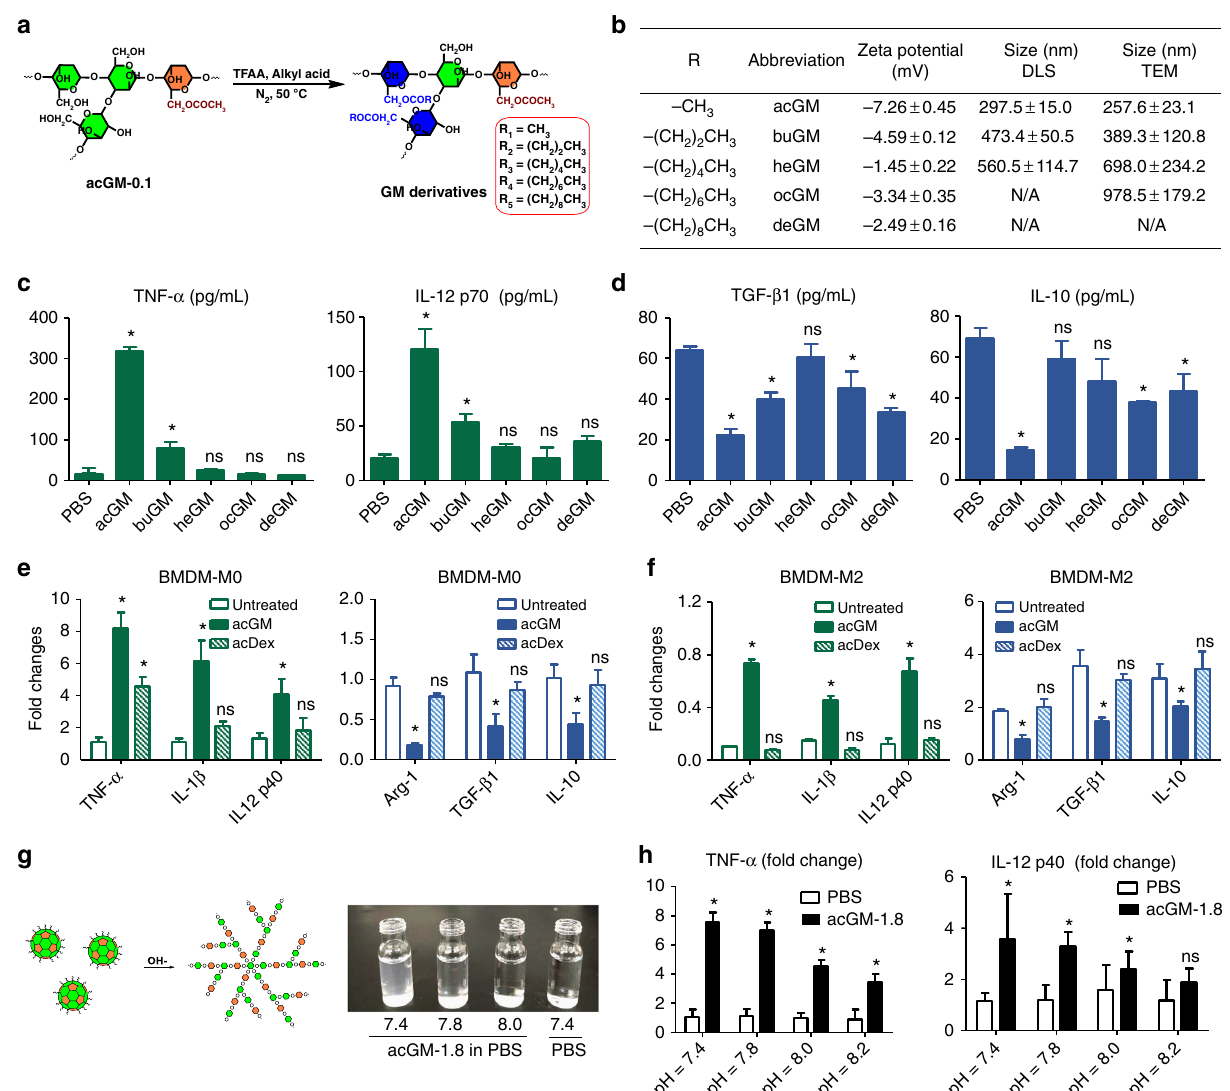
Fig. 3 Both “ ac ” and “ GM ” are essential for the function of acGM-1.8. a Schematic illustration of preparing different GM derivatives. b Physical properties of the GM derivatives, including the type of aliphatic chain, zeta potential, and size determined by both dynamic light scattering (DLS) and transmission electron microscopy (TEM). c , d Determination of ( c ) proin fl ammatory cytokines TNF- α and IL-12 p70 and ( d ) anti-in fl ammatory cytokines TGF- β 1 and IL- 10 secreted by BMDM after 24 h of stimulation by various GM derivatives (* P < 0.05 vs. the PBS group; n = 3). e Fold changes of markers for macrophage polarization (M1: TNF- α , IL-1 β , and IL-12 p40; M2: Arg-1, TGF- β 1, and IL-10) in BMDM (BMDM-M0) treated with PBS, acGM, or acetyl dextran (acDex) for 24 h (* P < 0.05 versus the PBS group; ns: no signi fi cance; n = 3). f Fold changes of markers for macrophage polarization (M1: TNF- α , IL-1 β , and IL-12 p40; M2: Arg-1, TGF- β 1, and IL-10) in pre-induced M2-type BMDM (BMDM-M2) treated with PBS, acGM, or acetyl dextran (acDex) for 24 h. (* P < 0.05 vs. the PBS group; ns: no signi fi cance; the fold changes were normalized to those of M0; n = 3). g (left) Schematic illustration of breaking the acGM assemblies by alkaline solution and (right) the appearance of acGM-1.8 in PBS under different pH values (7.4, 7.8, and 8.0) compared with PBS. h Fold changes of proin fl ammatory cytokines (TNF- α and IL-12 p40) expressed by BMDM after incubation with PBS or acGM-1.8 under different pH values (7.4, 7.8, and 8.0; * P < 0.05 versus the PBS group; ns: no signi fi cance; n = 3). Data are representative for three independent experiments; ns: no signi fi